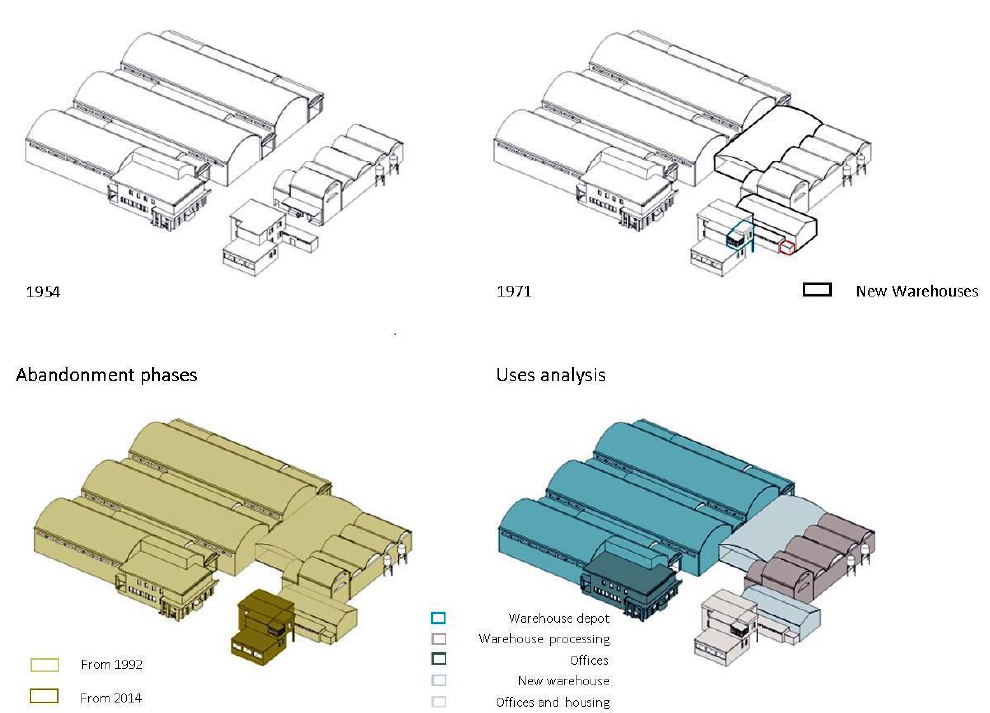
Figure 2. Building additions from 1954 to 1971 ( top ), abandonment, and layout of the former activities ( bottom ).